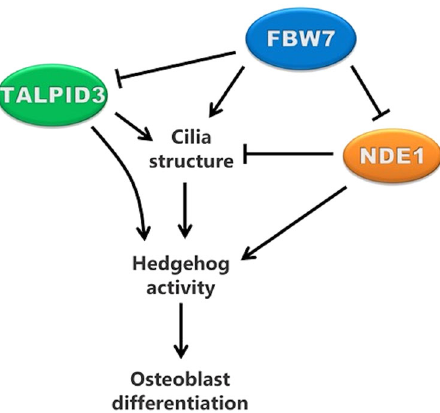
Fig. 8 Working model. Working model depicting the role of the FBW7 – NDE1 – TALPID3 pathway in primary cilia structure, Hedgehog pathway activity, and osteoblast